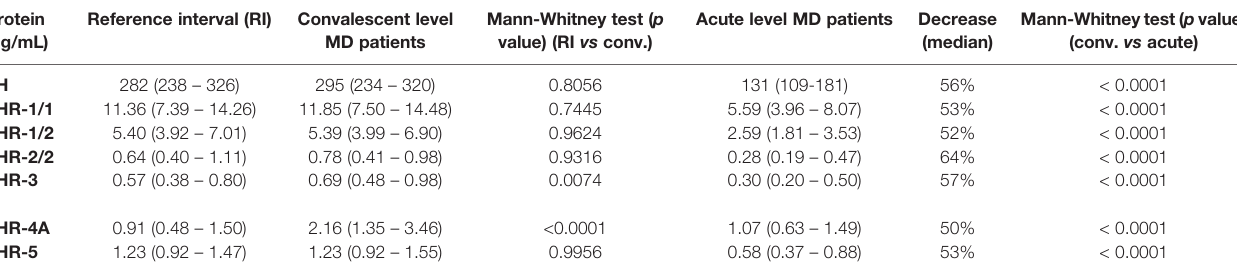
TABLE 2 | FH protein family ranges during MD. Protein (µg/mL)